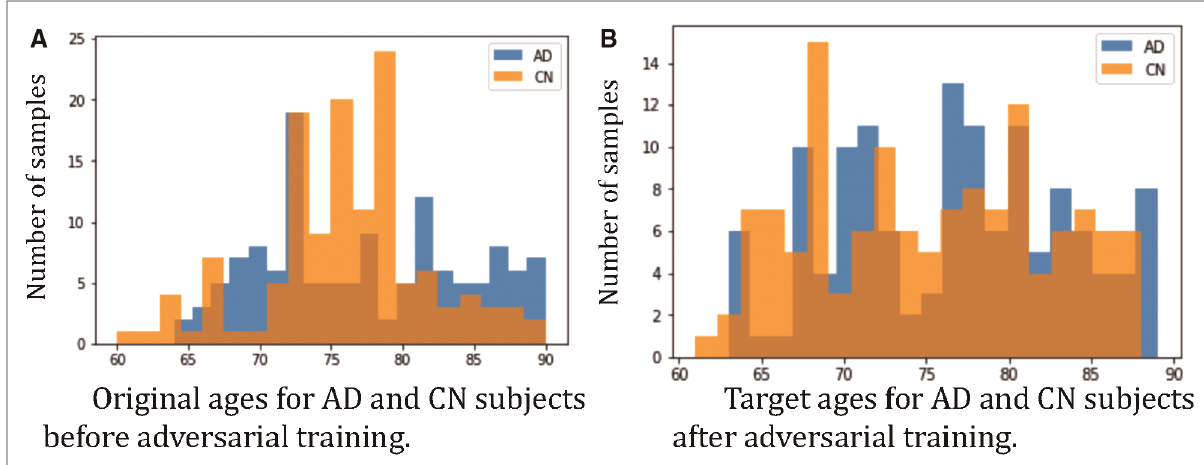
FIGURE 2 Histograms of ages of subjects before and after adversarial learning. We can observe that adversarial training aims to balance the data.